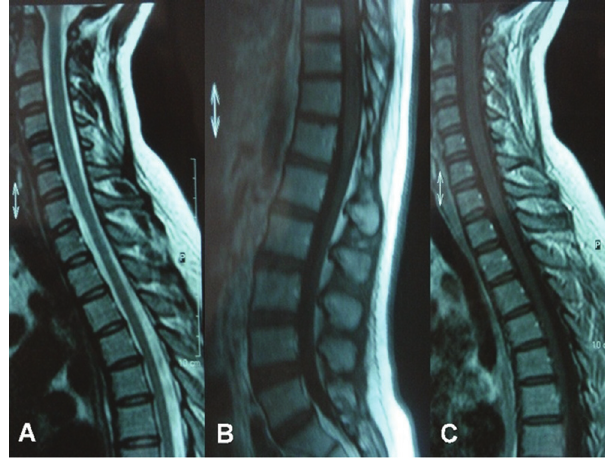
Figure 4 - Non-contrast T2-weighted image of the cervical and thoracic spinal cord (a), contrast sagittal T1-weighted image of the conus medullaris (b), and contrast T1-weighted image of the cervical and thoracic spinal cord (c) reveal normal